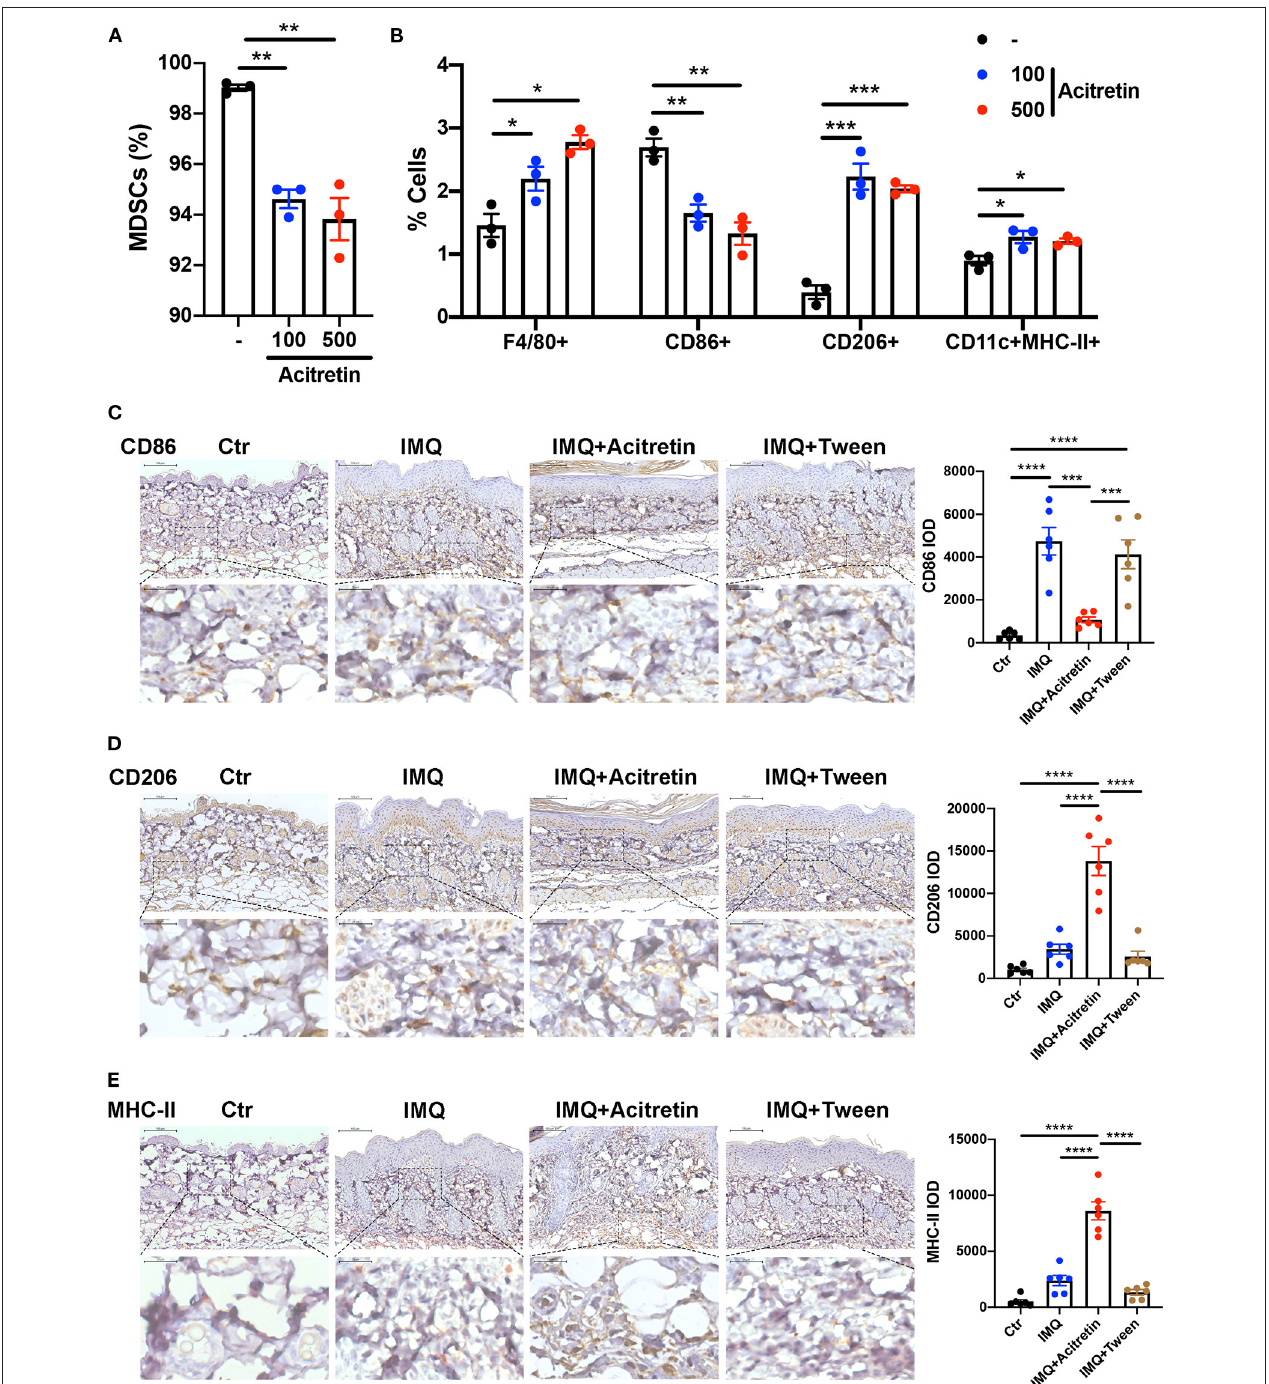
FIGURE 3 | Acitretin promoted the differentiation of MDSCs. (A,B) MDSCs were isolated from the bone marrow of IMQ-induced model mice and cultured for 4 days with 20ng/mL GM-CSF. Acitretin (100ng/mL or 500ng/mL) or vehicle control (-) was added on days 1 and 3. (A) The percentages of MDSCs treated with acitretin. (B) The effect of acitretin on differentiation of MDSCs into F4/80 + macrophage, CD86 + M1 macrophage, CD206 + M2 macrophage, and CD11c + MHC II + dendritic cells. The presence of different cell populations was evaluated by flow cytometry. (C–E) IMQ-induced psoriasis-like model mice treated with oral acitretin or tween (solvent) once per day for 6 days. Paraffin sections of the back skin of Control (Ctr), IMQ, IMQ + Acitretin, and IMQ + Tween group were stained for CD86, CD206, and MHC-II by immunohistochemistry. CD86 IOD, CD206 IOD, and MHC-II IOD measured by image pro plus 6.0 expressed the CD86, CD206, and MHC-II expression. (C) CD86 stain, (D) CD206 stain, (E) MHC-II stain. Scale bars: 100 µ m (upper panel), scale bars: 20 µ m (lower panel). Statistical data are shown in the right panel. All results represent at least three independent experiments. Data represent the mean ± SEM. * p < 0.05, ** p < 0.01, *** p < 0.001, **** p < 0.0001.